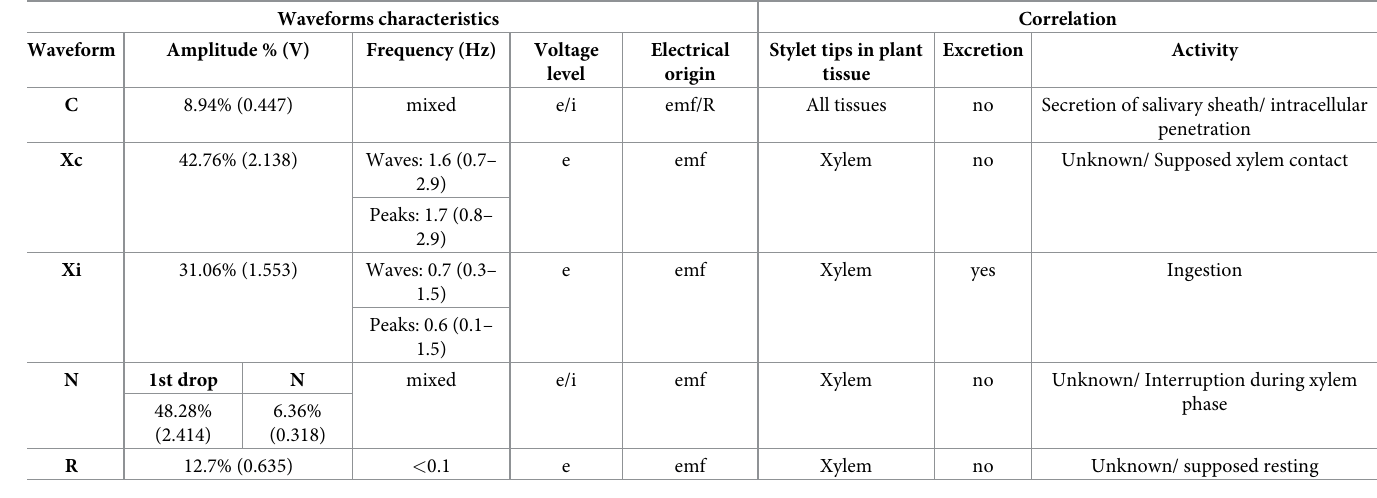
Table 1. Waveforms characteristics and biological meaning.